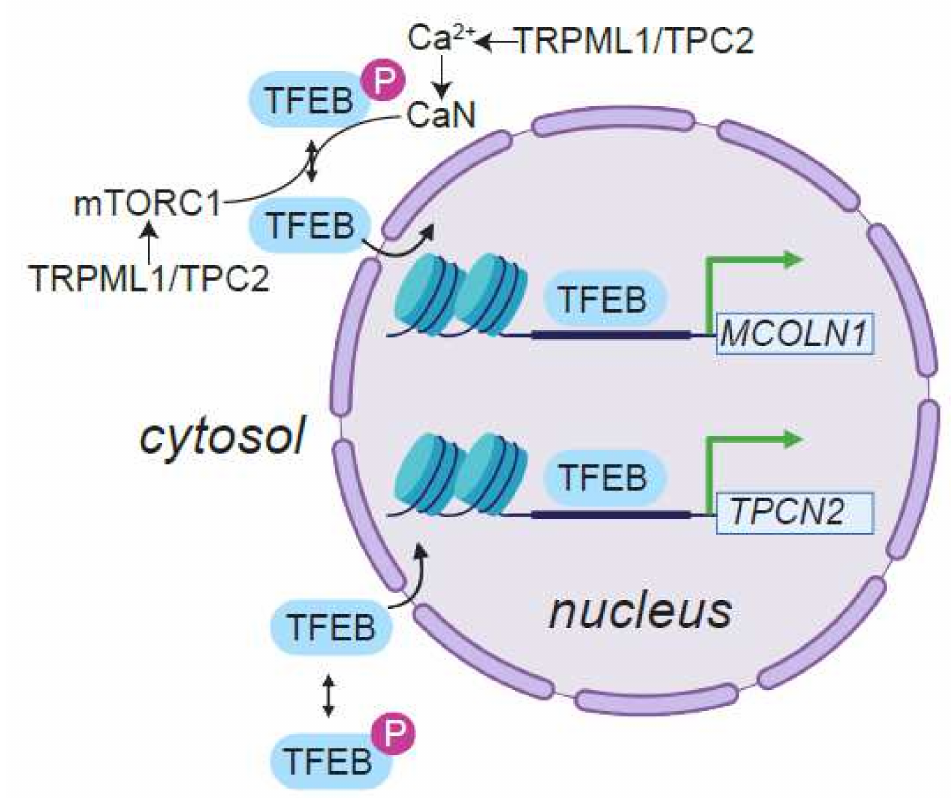
Figure 6. Transcriptional regulation of genes encoding endolysosomal ion channels. Within the cell nucleus, TFEB, and related transcription factors such as TFE3 and MITF, bind to the promoters of genes that encode autophagy and endolysosomal proteins. Figure shows dephosphorylated TFEB bound to the promoters of MCOLN1 and TPCN2 , which encode TRPML1 and TPC2, respectively. Phosphorylated TFEB is retained in the cytosol leading to diminished expression of endolysosomal genes. TRPML1 and TPC2 are endolysosomal cation channels that regulate nucleocytoplasmic translocation of TFEB activity in different ways. By driving autophagic and endolysosomal flux, TRPML1 and TPC2 are needed for mTORC1 activation, which in turn, phosphorylates TFEB leading to retention of the transcription factor in the cytosol. On the other hand, release of endolysosomal Ca 2+ via TRPML1 and TPC2 activates calcineurin (CaN), which dephosphorylates TFEB, and thereby, promotes the translocation of the transcription factor into the nucleus. Image created with